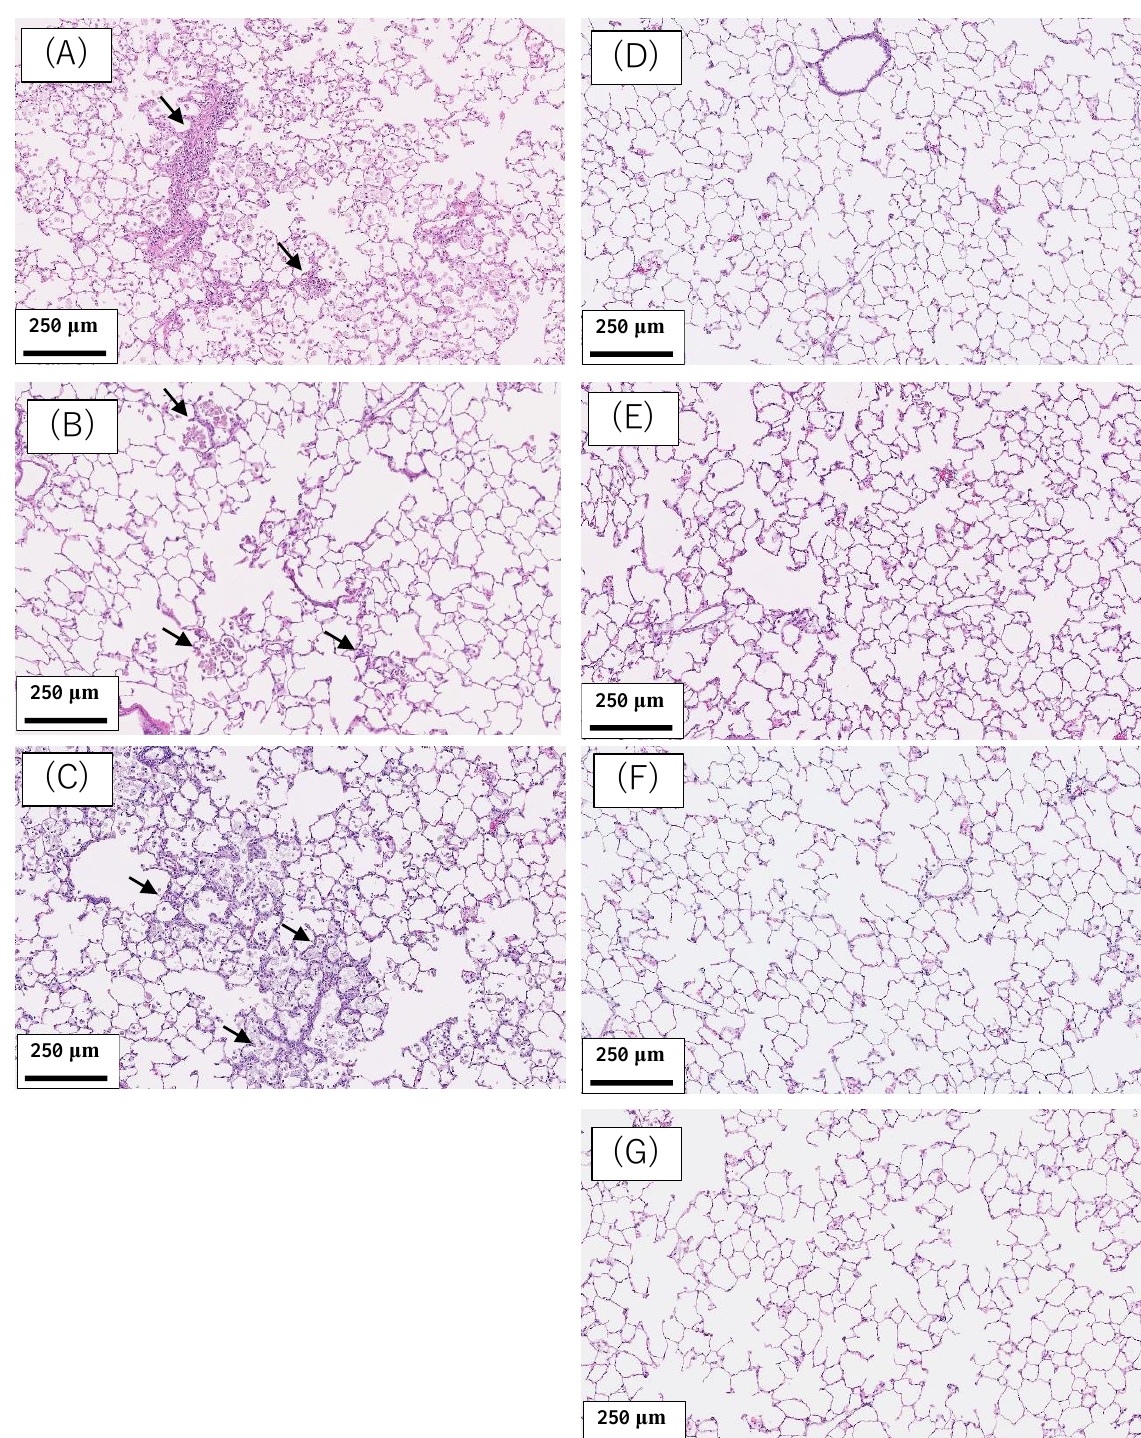
Figure 1. Pathological findings in the rat lung at 6 months after intratracheal instillation of 5 nanomaterials and micron- particles of SiO 2 . ( A ) 1 mg NiO-exposed lung. ( B ) 1 mg CeO 2 -exposed lung. ( C ) 1 mg SiO 2 -exposed lung. ( D ) 1 mg TiO 2 (P90)-exposed lung. ( E ) 1 mg TiO 2 (rutile)-exposed lung. ( F ) 1 mg ZnO-exposed lung. ( G ) Negative control in intratracheal instillation (distilled water). Infiltration of inflammatory cells was observed in Figure 1( A – C ) (black arrows).